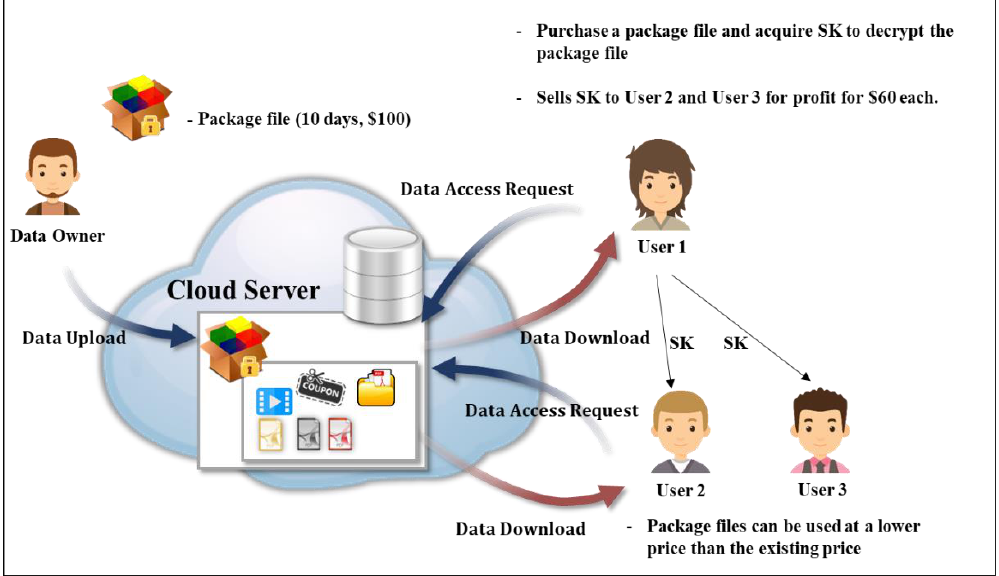
Figure 4. Key abuse and misuse issues that can occur in the CP-ABE data sharing system.